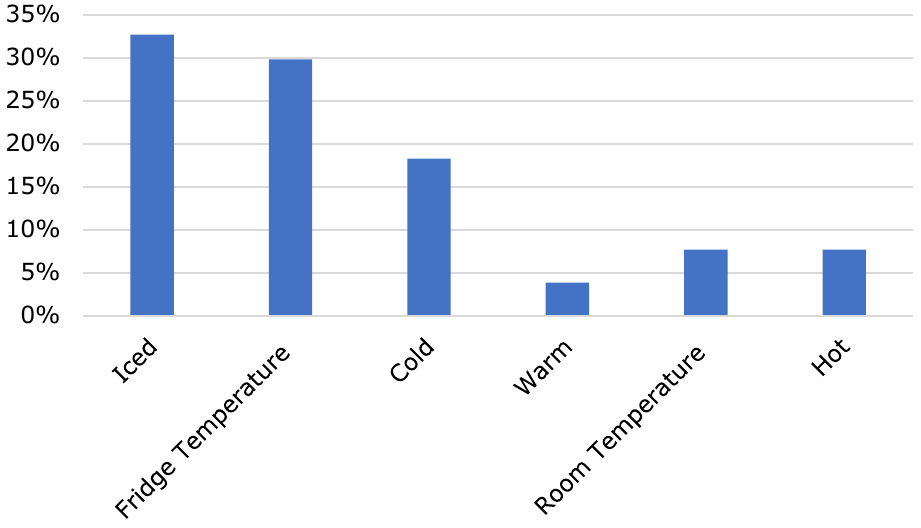
Figure 6. Consumption temperature of cold brew coffee (temperatures up to 4 ◦ C: “Iced”; 5 to 8 ◦ C: “Fridge Temperature”; 9 to 12 ◦ C: “Cold”; 13 to 15 ◦ C: “Warm”; 16 to 33 ◦ C: “Room Temperature”; temperatures above this: “Hot”).